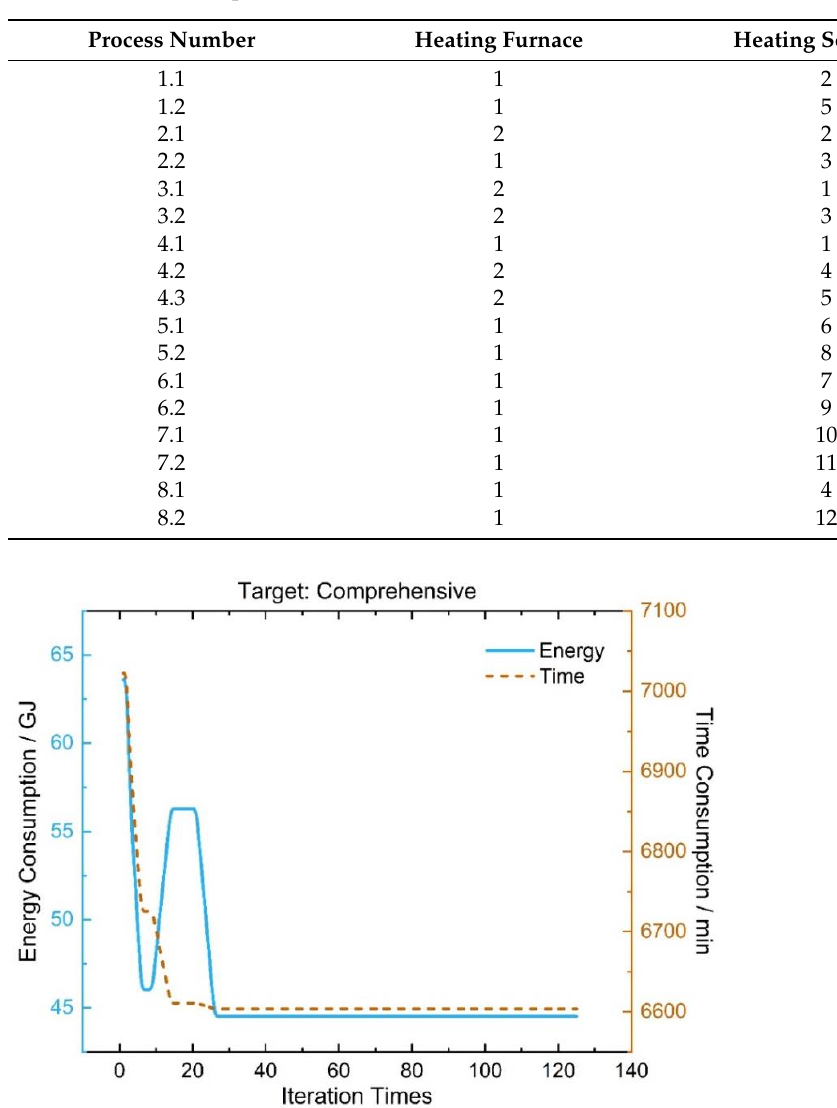
Table 6. Batch 1 final optimization result.